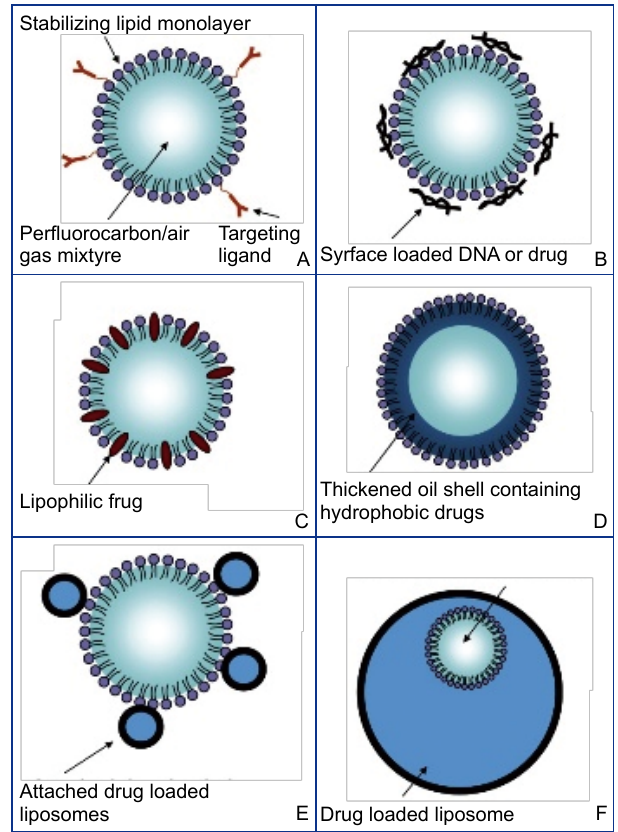
Stabilizing lipid monolayer